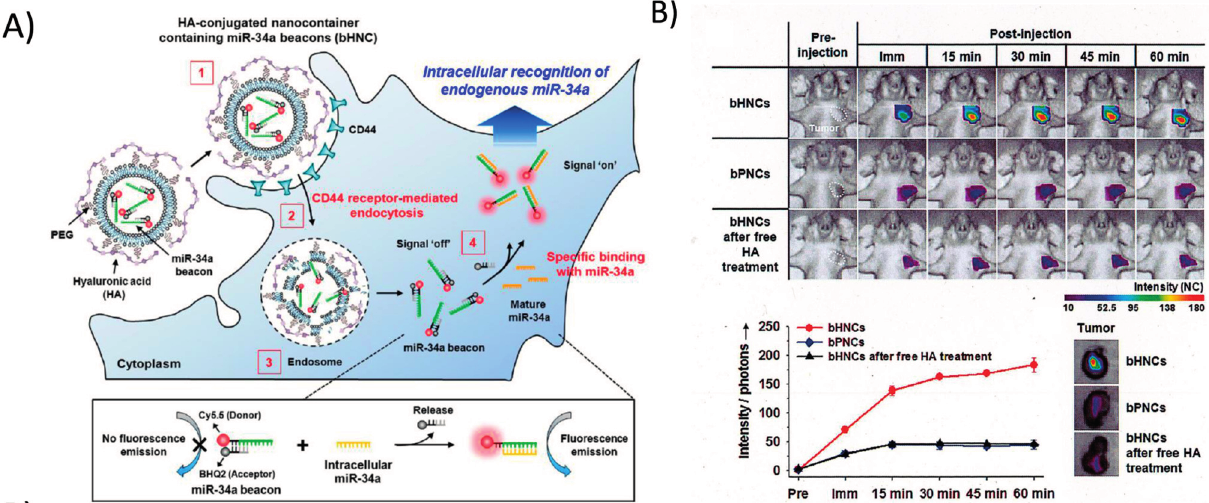
Figure 2. ( A ) Schematic illustration of theranostic miRNA-34a molecular beacon (MB) delivery system to target breast cancer cells in vivo . The system is based on hyaluronic acid coated-nanocontainers which bind to CD44 receptors of tumour cells (1) for efficient internalizationin endosomes (2); Next, the miRNA MB is released from the nanoparticles under acidic pH (3) and can bind to the miRNA-34a in the cytosol (4); Upon binding, the fluorophore Cy5.5 is no longer quenched by the BHQ2 quencher and can emit fluorescence upon excitation at the requested wavelength; and ( B ) In vivo and ex vivo imaging of miR-34a in an orthotopic breast cancer model. Top panel. In vivo optical fluorescence images of MDA-MB-231 tumour-bearing mice after intravenous injection of either miRNA-34a MBs (bHNCs), control nanocarriers without miRNA-34a MB (bPNCs) or mice treated with bHNCS plus free hyaluronic acid; Lower left panel . Total photon counts in tumour regions after administration of bHNCs, bPNCs, and bHNCs plus free HA treatment; Lower right panel : Ex vivo optical fluorescence images of tumours excised at 1 h post-injection of bHNCs, bPNCs, and bHNCs plus free HA treatment, respectively. Reprinted and adapted with permission from